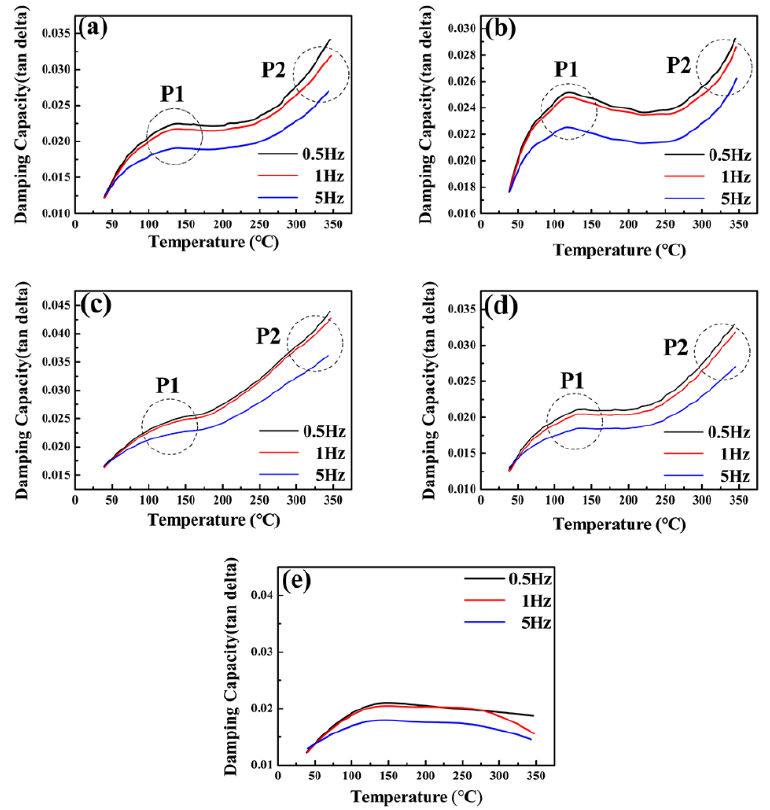
Figure 8. Damping capacity of the SiC ceramic infiltrated by Al alloy with different Si content: ( a ) 5 wt. %, ( b ) 10 wt. %, ( c ) 15 w. t%, ( d ) 20 wt. %, and ( e ) initial SiC ceramic.